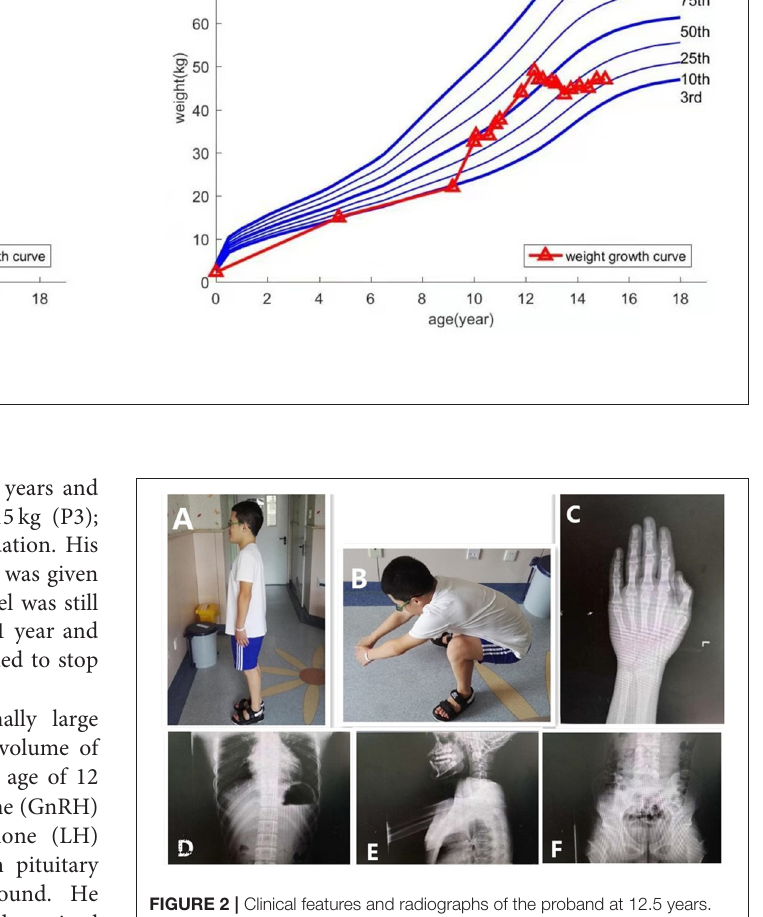
FIGURE 2 | Clinical features and radiographs of the proband at 12.5 years. Special facial features: small ears, prognathism, and short fingers (A) . Difficulty in squatting (B) . The bone age in the image of the left hand was 16.5 years old; the phalanges were short (C) . Anteroposterior and lateral images of